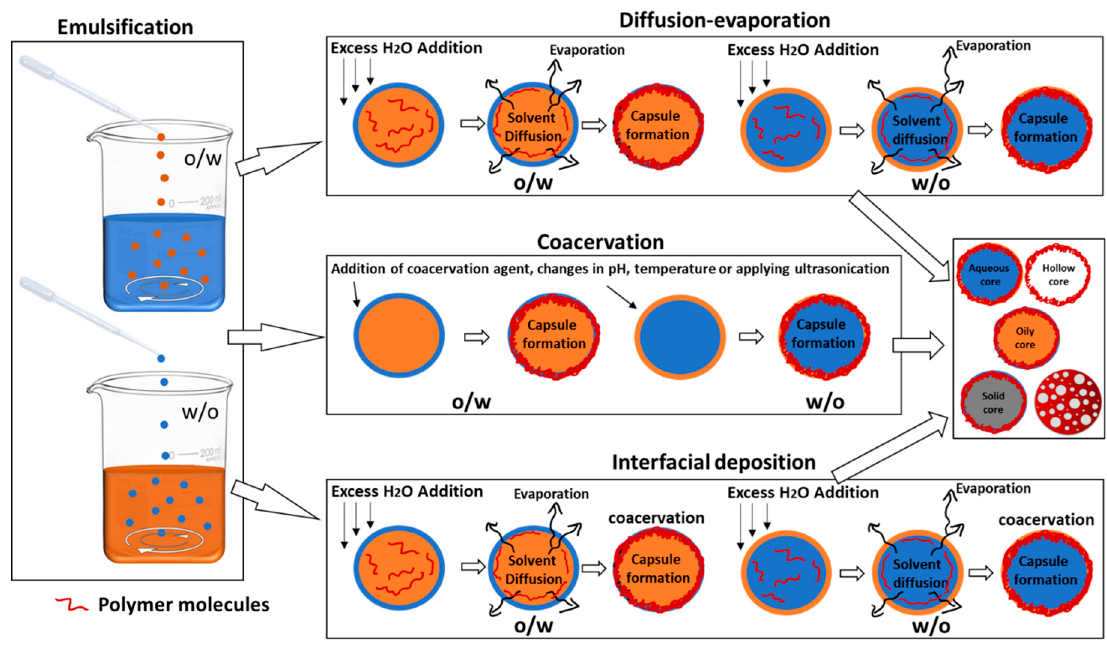
Figure 4. Schematic diagram of emulsion templating approach.